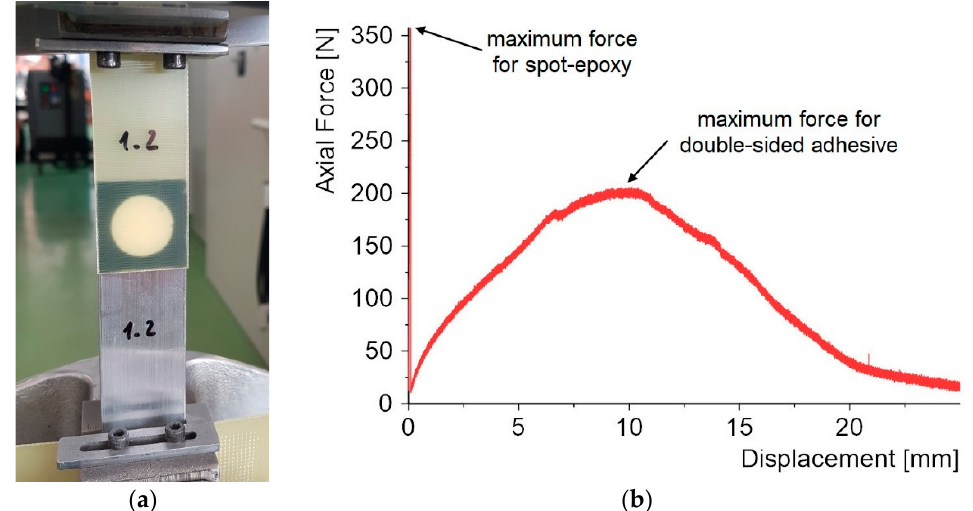
Figure 5. Static tensile test for dual-adhesive type specimens: ( a ) specimen during testing, ( b ) force–displacement diagram (specimen 1_2).